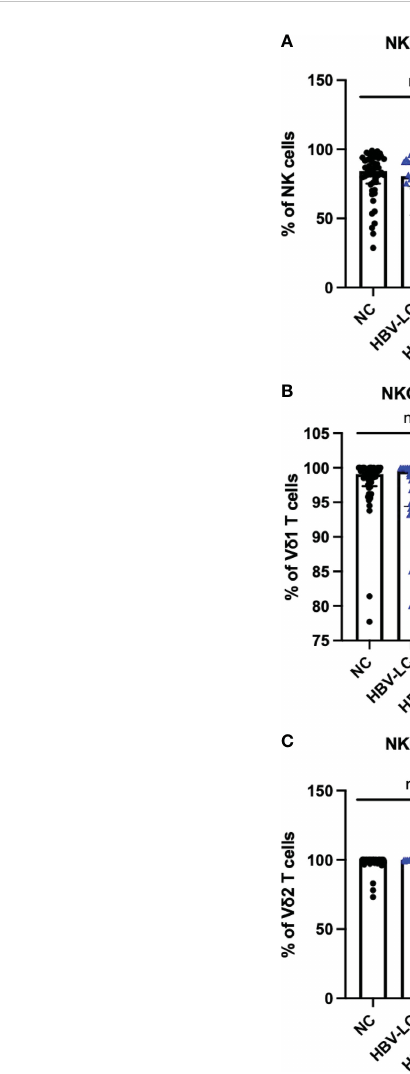
FIGURE 5 Expression of activating receptors on NK cells and gd T cells. (A) Expression of NKG2D, NKP30, NKP46 on the surface of NK cells. (B) The expression of NKG2D, NKp30, NKp46 on the surface of V d 1 cells. (C) The expression of NKG2D, NKP30, NKP46 on the surface of V d 2 cells. * p <0.05. ns, not signi fi